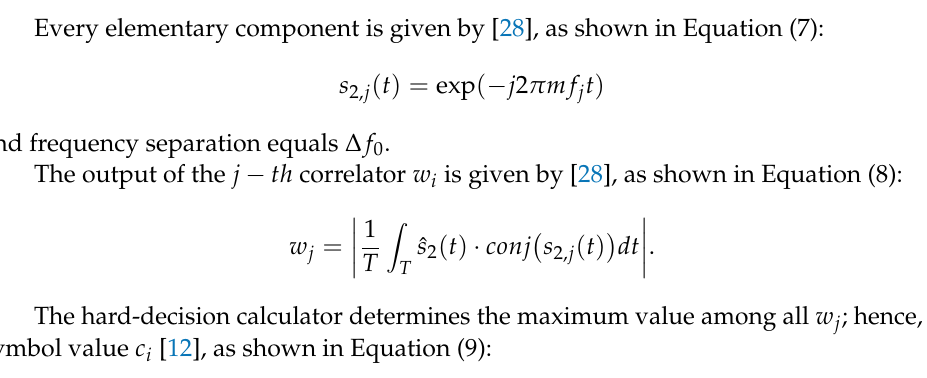
Figure 11. Block diagram of the 8FSK correlator-based hard and soft demodulator.